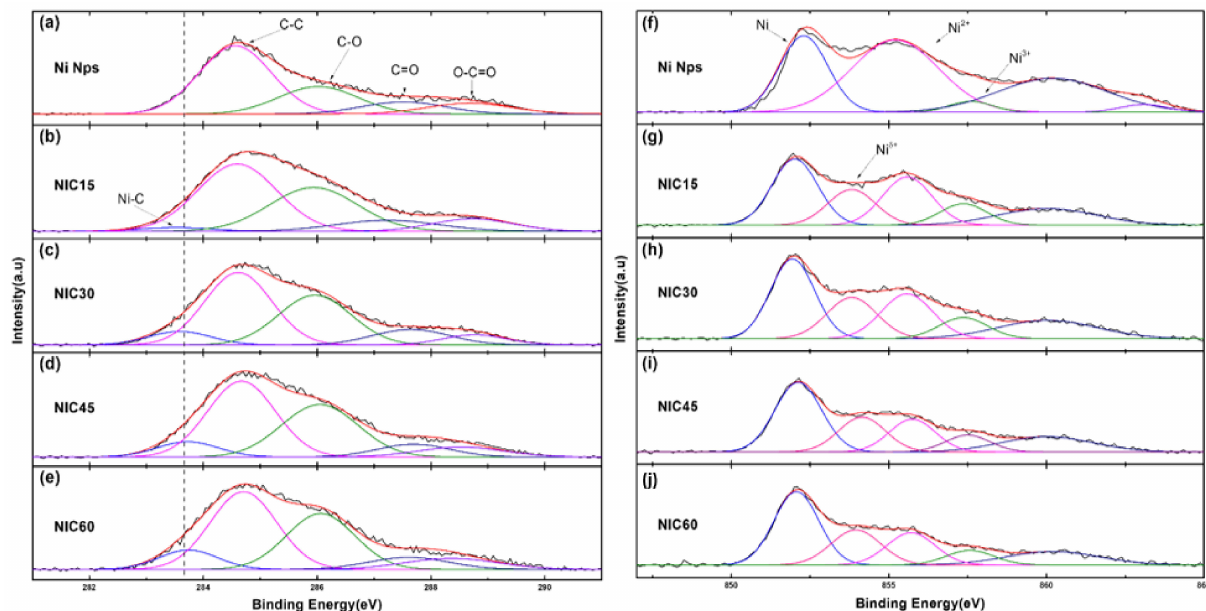
Figure 6. XPS C1s data of ( a ) Ni Nps, ( b ) NIC15, ( c ) NIC30, ( d ) NIC45, and ( e ) NIC60. XPS Ni2P 2/3 data of ( f ) Ni Nps, ( g ) NIC15, ( h ) NIC30, ( i ) NIC45, and ( j ) NIC60.